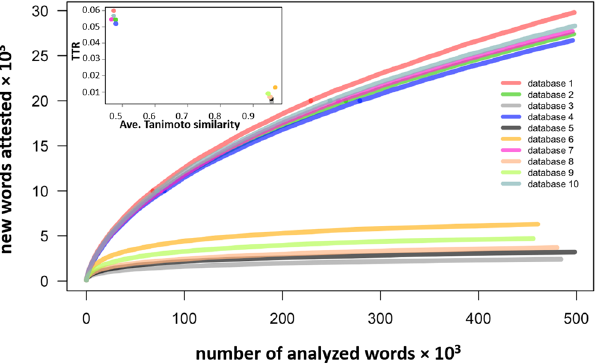
Figure 3. Linguistic measures of diversity in commercial chemical libraries. The main graph illustrates the Heaps’ law (i.e., the number of new MCS chemical words found when scanning through the “vocabulary” characterizing a particular molecule collection) for ten samples of commercial databases from the Mcule company. Each sample comprises 1,000 molecules and (1,000·1,000/2) − 1,000 = 499,000 pairwise comparisons between different molecules are made to derive its MCS vocabulary. Inset plots TTR values for each database against Mcule’s Tanimoto-based similarity